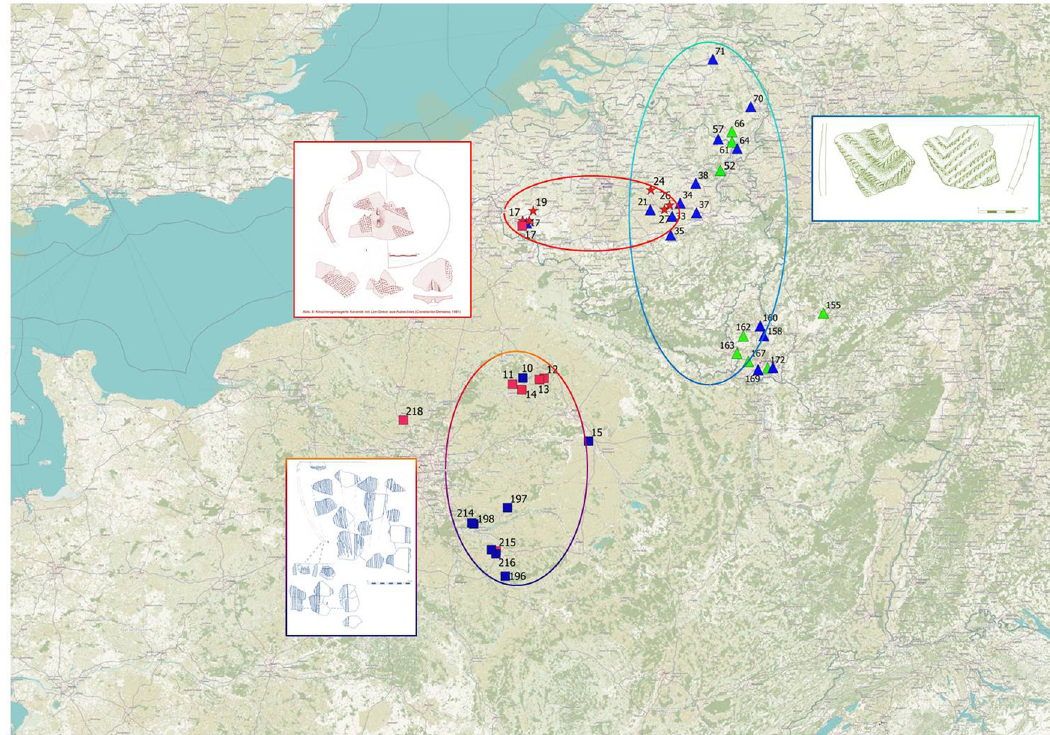
Figure 5: Distribution areas of regional decoration patterns. Examples from Gassel and Sehndorf ( right ) with organic and mineral temper ( blue and green ) , Auchechies ( top left ) with bone temper ( red ) , and Cuiry - lès - Chaudardes ( bottom left ) with mineral and bone temper ( blue and red ) . ( Drawing: Author with fi gures from Brounen & de Jong, 1988, p. 185, Figure 3a; Constantin & Demarez, 1981, p. 219, Figure 7; Constantin, 1985, pl. 76 378.1,2; Fritsch, 2000b, p. 232, pl. 1.1 )